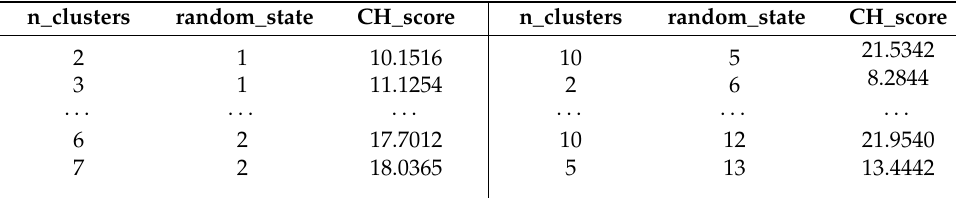
Table 3. Basis for selection of SC algorithm parameters.